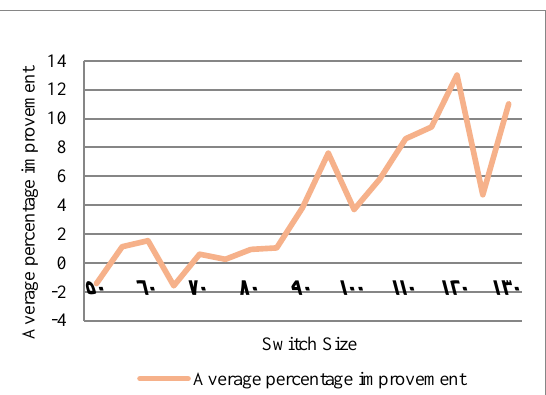
Figure 2. Average percentage of improvement of the ILS algorithm compared to CPLEX.